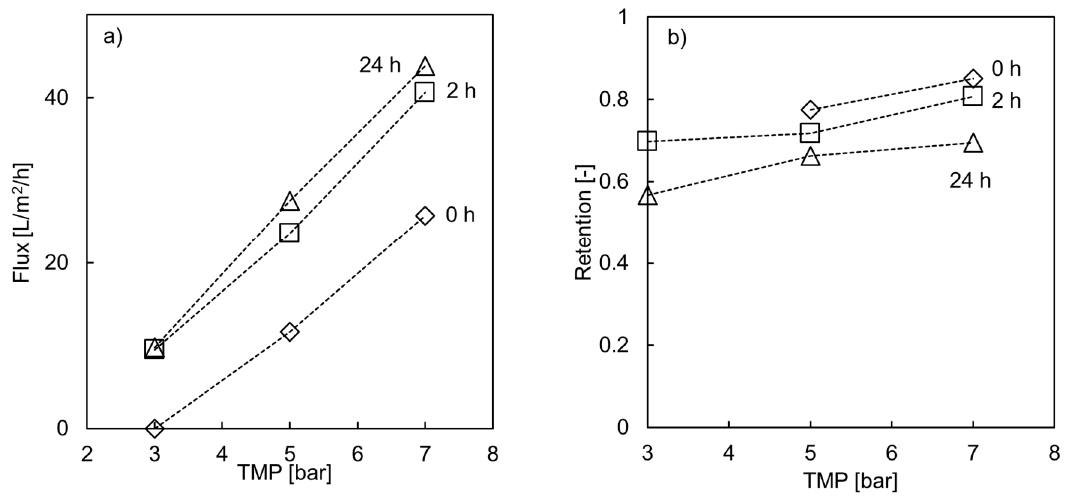
Figure 5. ( a ) Flux and ( b ) Mg retention for 500 mM MgSO 4 feed solution for sPES (PDADMAC/PSS) 4 as a function of TMP before and after filtering a 15% H 3 PO 4 solution for two and 24 h (Re > 2’300).